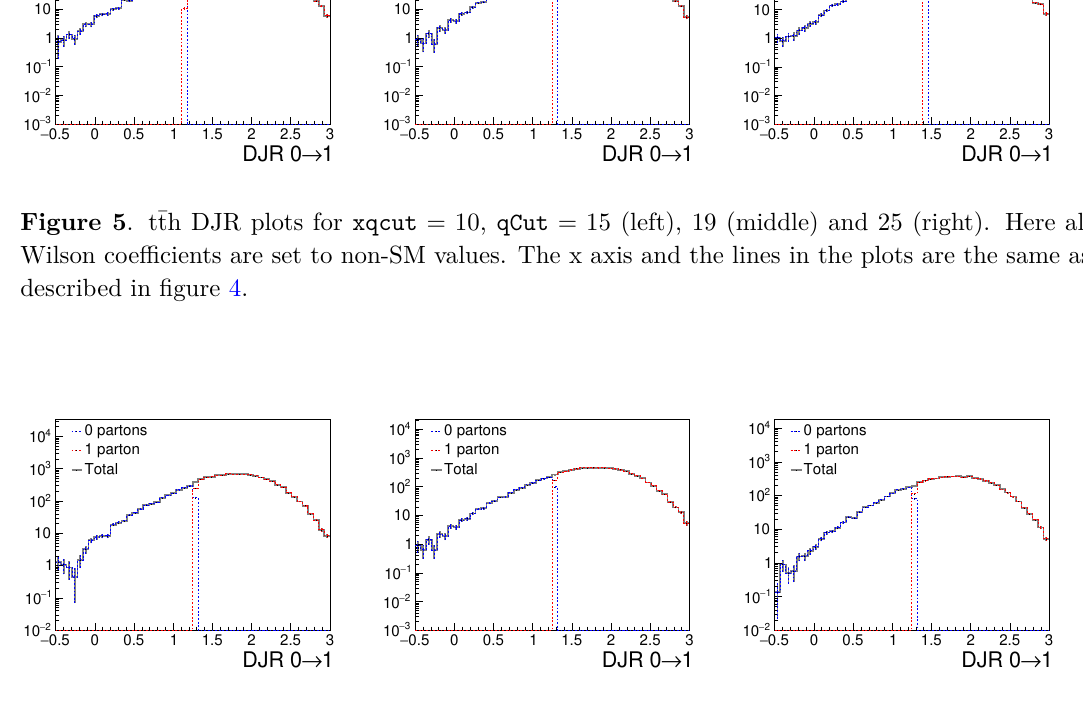
Figure 6 . t¯th DJR plots for qCut = 19 , xqcut = 5 (left), 10 (middle) and 15 (right). Here all Wilson coefficients are set to non-SM values. The x axis and the lines in the plots are the same as described in figure